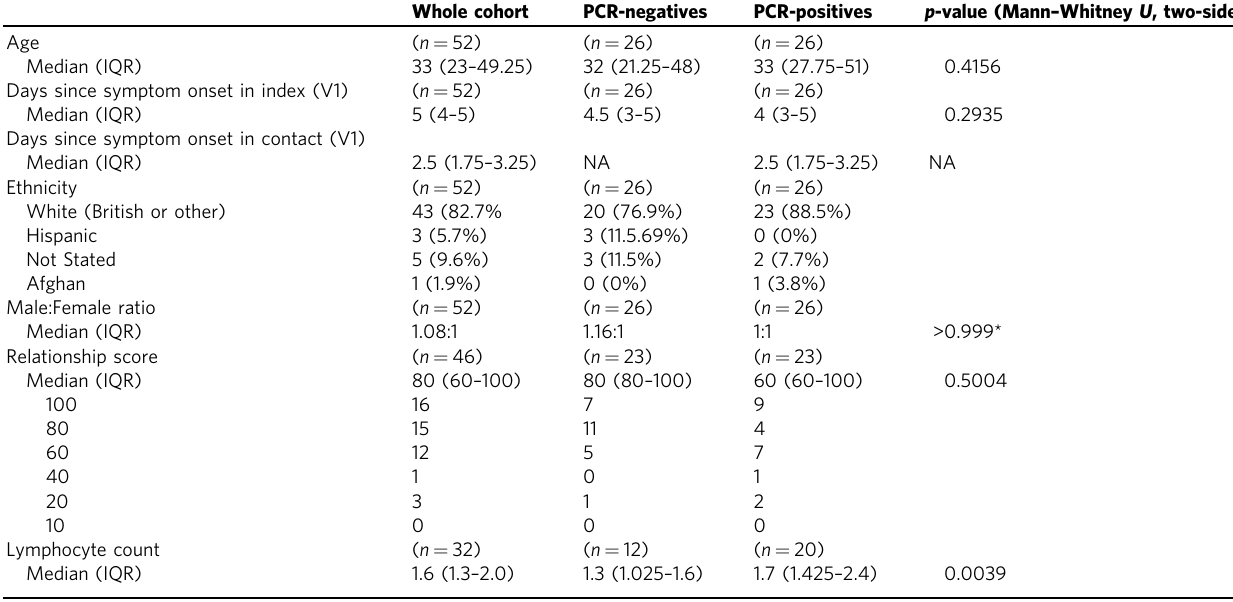
Table 1 Demographics for the whole cohort, PCR-positive and PCR-negative contacts of con fi rmed COVID-19 cases. Whole cohort PCR-negatives